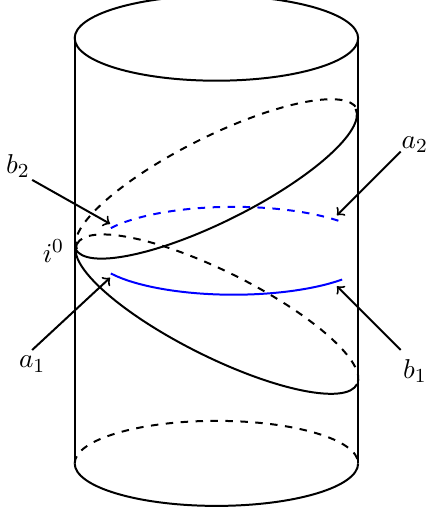
Figure 6 . We plot the function tan (cid:18) ( (cid:28) ) for the example shown in (cid:12)gure 4 and 5. The function is not the same for di(cid:11)erent chiral modes, as one has to substitute in the correct de(cid:12)nition of a 1 ; b 1 ; a 2 ; b 2 as mentioned after (2.19). The maximal value of j tan (cid:18) ( (cid:28) ) j achieved for the example is approximately 0 : 68. Since tan (cid:18) ( (cid:28) ) does not go to in(cid:12)nity, an operator in one interval is not completely transferred to the other in this example.